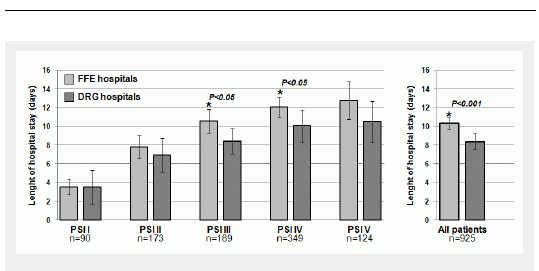
Length of Hospital stay according to severity of pneumonia in hospitals with a FFS system (light gray) or a DRG system (dark gray); asterisk refers to significant difference of FFE compared to DRG hospital.